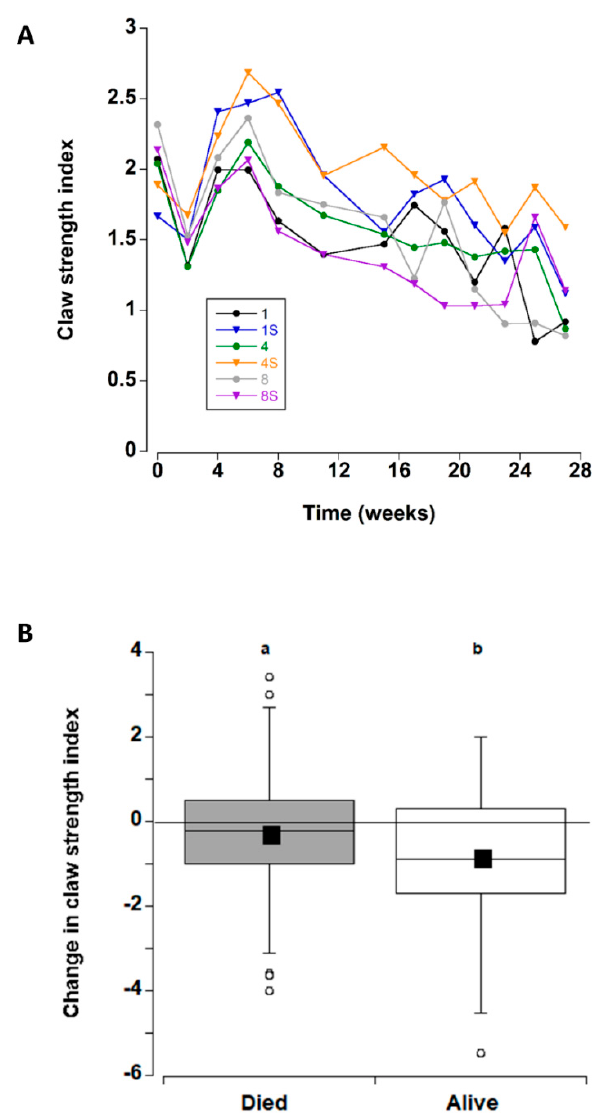
Figure 3. ( A ) Claw strength index values (strength/propodus height) for C. maenas (mean ± SE) kept in densities of 1, 4 or 8 crabs, with (S) or without shelter ( n = 24 per treatment) for six months in the laboratory ( B ) Change in claw strength index (between first and last measurement) for individual crabs. If a crab died or lost/broke a claw during the experiment, the last measured value was used. In this case, the changes are shown between crabs that died/ceased to be recorded during the experiment and those that survived during the experiment (data for the 6 different treatments was combined). The box plots represent the 75% confidence intervals, whiskers indicate the 95% confidence limits of the data, the horizontal line is the median number and the square is the mean number of limbs lost. Different letters above each box represent significant differences ( p < 0.05).